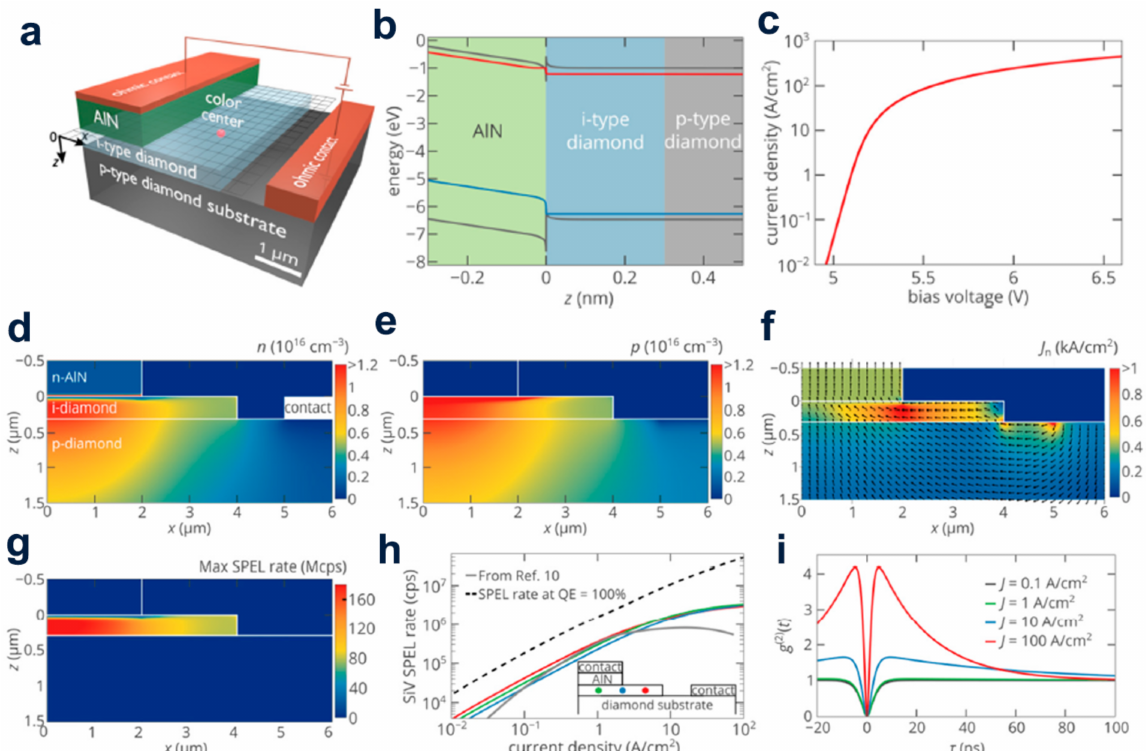
Figure 1. ( a ) Schematic diagram of AlN/diamond Single Photon Light-Emitting Diode (SPED). ( b ) En- ergy band diagram of near aluminum nitride/diamond heterojunction at 6.5 V. ( c ) The relationship between the current density of the top n-type contact and the bias voltage of the speed. The electron density ( d ), distribution of hole density ( e ) and electron current density ( f ) in speed when the bias voltage is 6.5 V. ( g ) Correlation between the single photon electroluminescence (SPEL) tempo of the SiV center, and displays its place and velocity in the i-type diamond area. ( h ) Relationship of the trait of the SPEL speed at the center of SiV on the injection current at three distinct locations in the core of the i-region as displayed in the insertion diagram. ( i ) g ( 2 ) for different pumping levels, at x = 1 µ m, z = 150